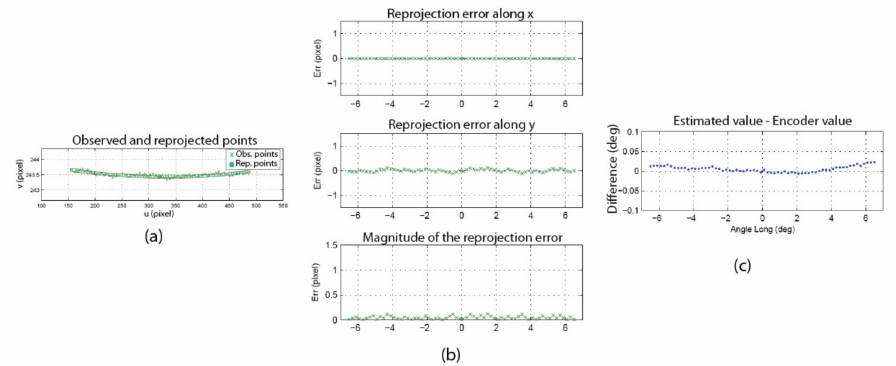
Figure 22. Observed speckle points and reprojected points obtained from the estimation of the axes and rotation angles ( a ). Reprojection error along X and Y in the image plane and magnitude of the reprojection error ( b ). Comparison of the estimated values of the rotation angles vs. the value read on the encoders on the axis ( c ). These plots are for the left